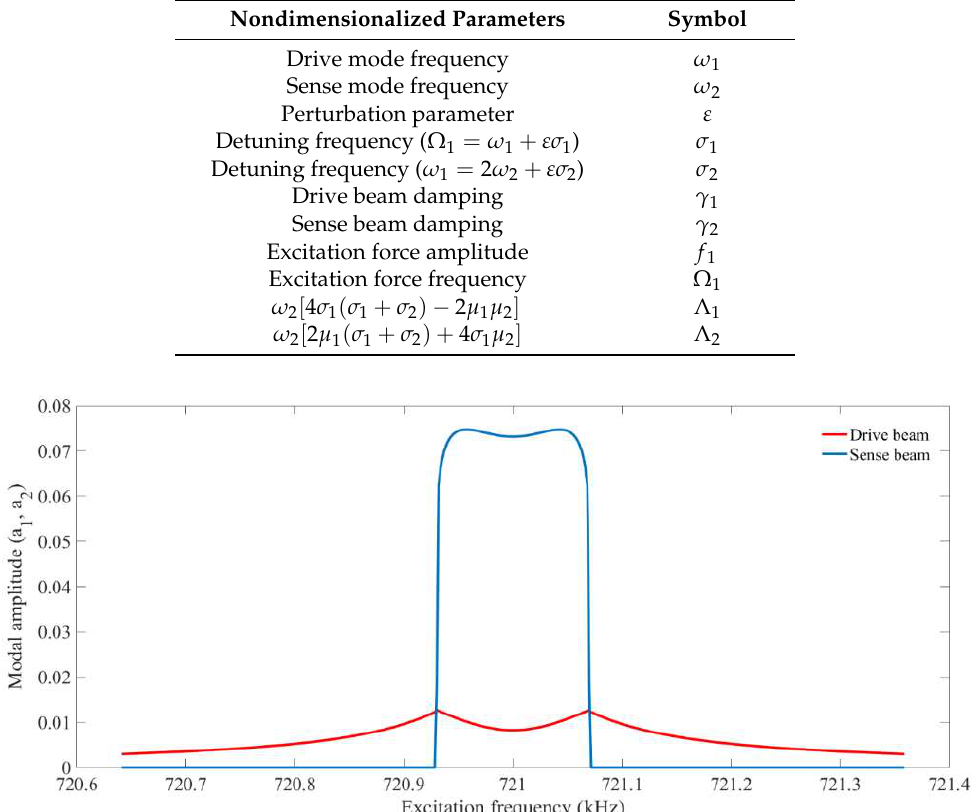
Figure 4. Simulated Nonlinear frequency sweep achieved from two-variable perturbation solution.